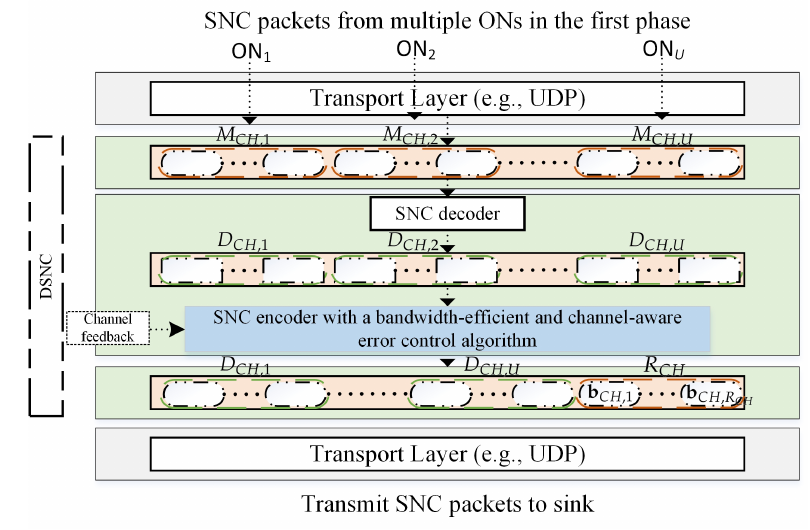
Figure 4. Proposed DSNC solution for multimedia